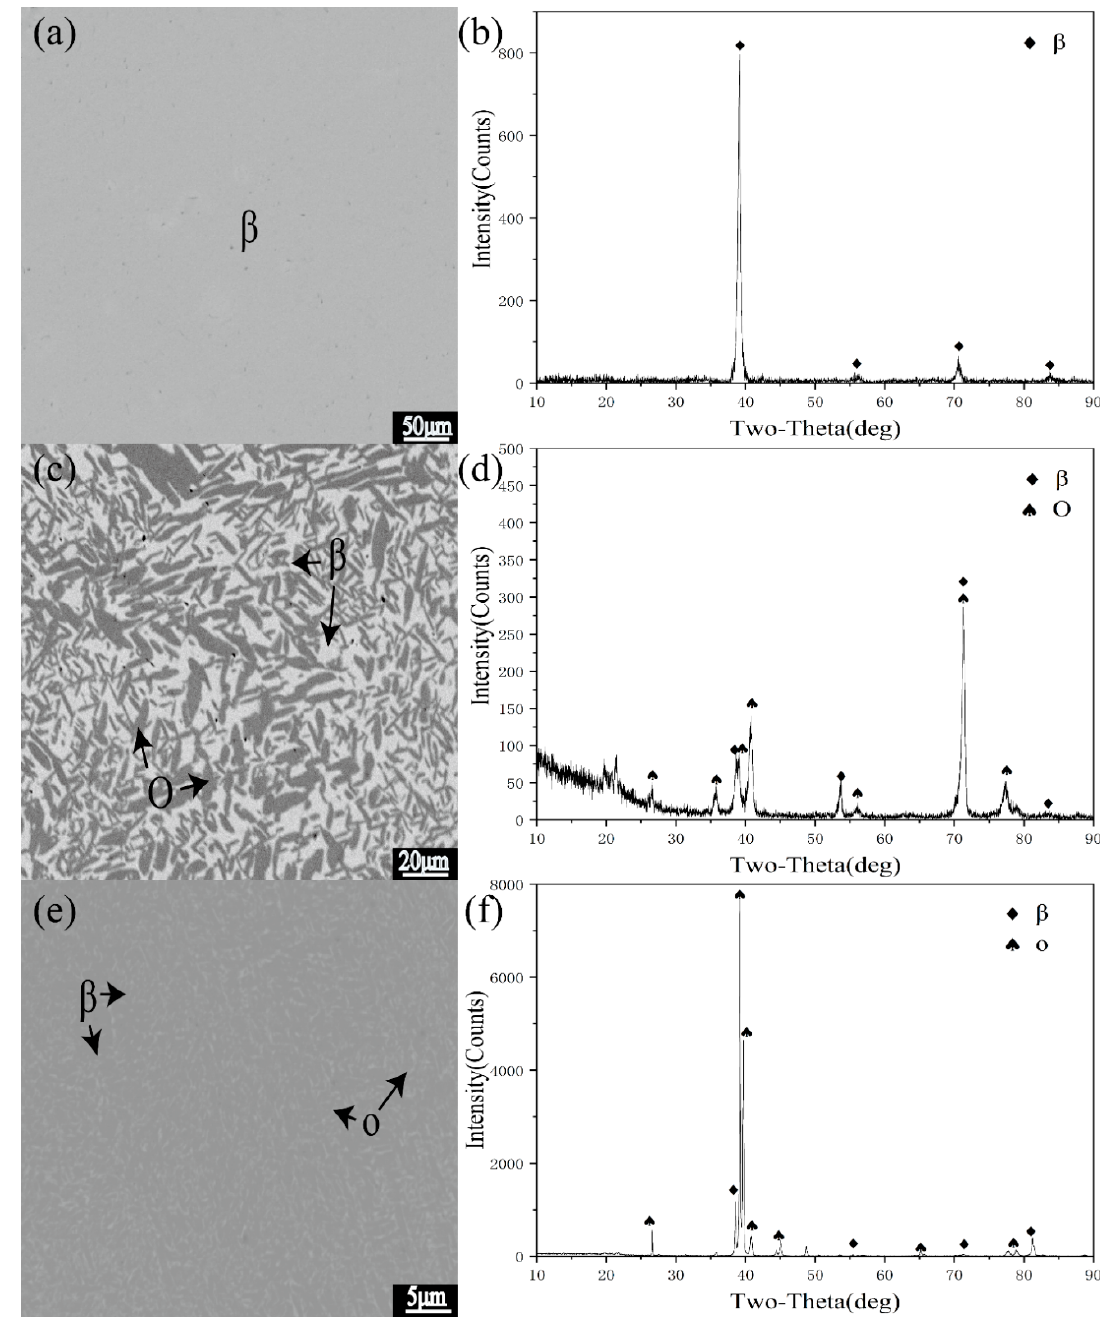
Figure 4. EPMA images and XRD results of alloy #5 after annealing at 1000, 900, 800 °C. ( a ) The microstructure of alloy #5 at 1000 °C; ( b ) the XRD result of alloy #5 at 1000 °C. ( c ) The microstructure of alloy #5 at 900 °C; ( d ) the XRD result of alloy #5 at 900 °C. ( e ) The microstructure of alloy #5 at 800 °C; ( f ) the XRD result of alloy #5 at 800 °C.